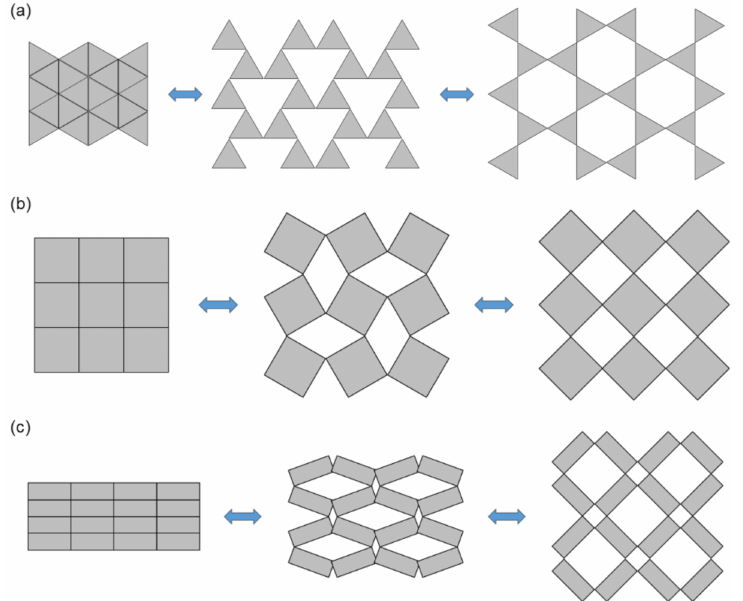
Figure 4. Rotating unit structures. ( a ) Triangle unit cells, ( b ) square unit cells, ( c ) rectangle unit cells [26,35–37]. (A figure was reproduced with permission from John Wiley and Sons